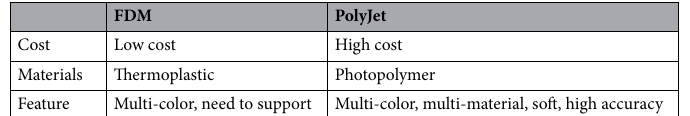
Table 1. Comparison of two types of 3D printing: FDM and PolyJet. FDM fused deposition modeling.